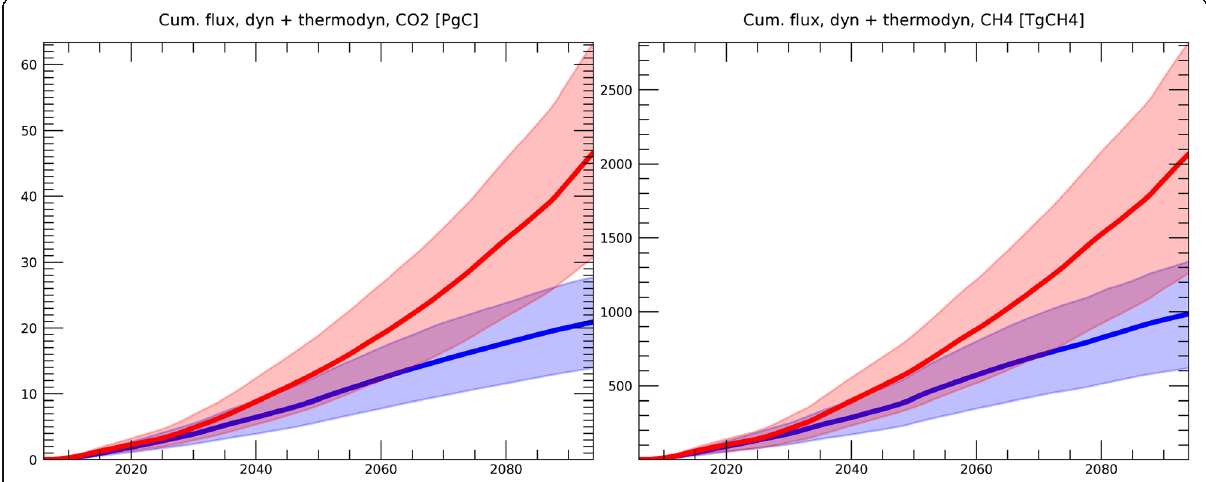
Fig. 4 Same as Fig. 2 but for the cumulative GHG flux due to the total (dynamic plus thermodynamic) degradation of permafrost for CO 2 and